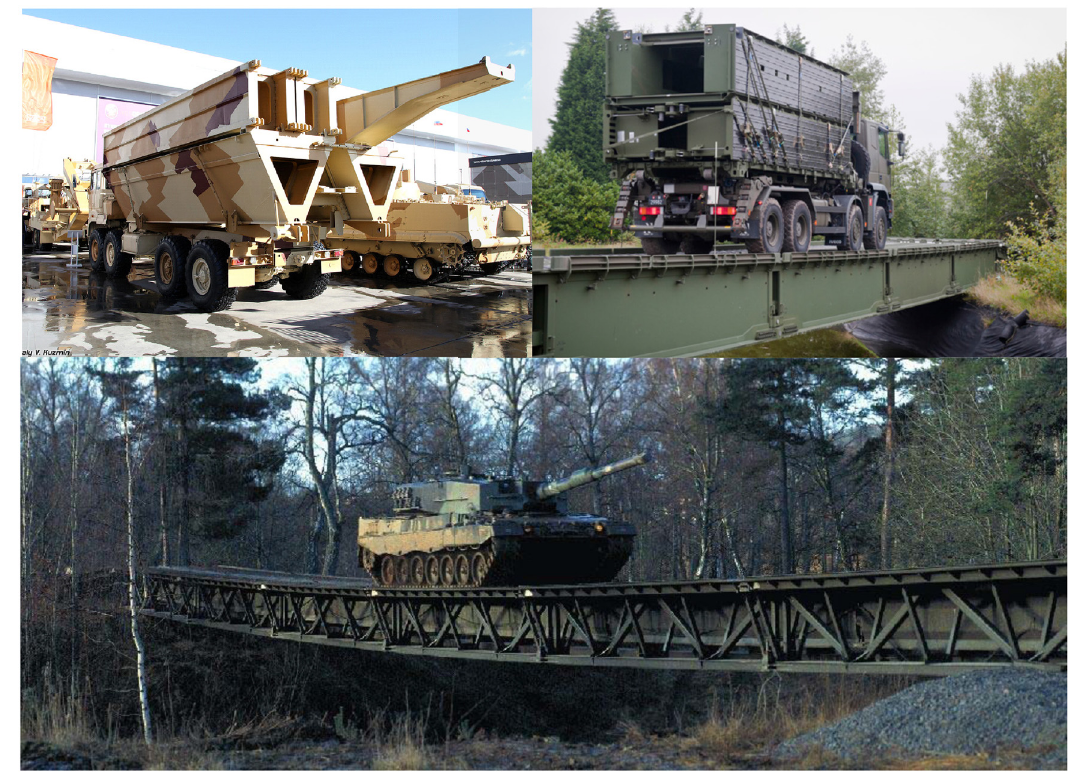
Figure 1: Bridge span designs, from the top left: MMK, DSB, and KB5 [ 2 ] .